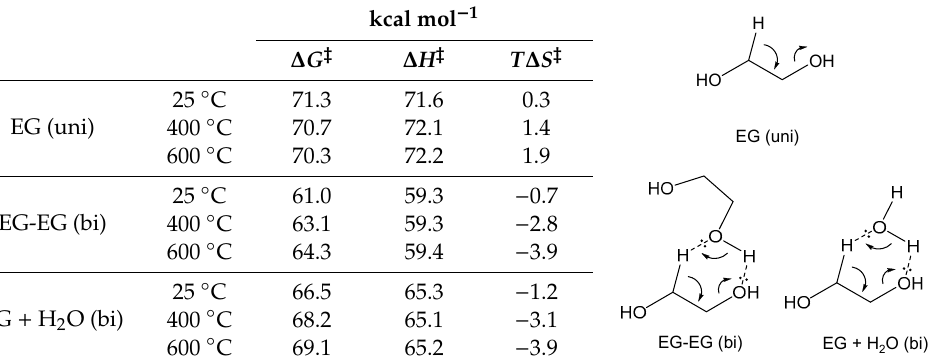
Figure 9. Possible heterolytic dehydration pathways for ethylene glycol (EG). The values next to the arrows represent the activation energies (kcal mol − 1 ), as calculated at the MP4(SDQ) // DFT(M06-2X) level. AA, acetaldehyde; uni, unimolecular mechanism; and bi, bimolecular mechanism (EG-EG). Table 2. The ∆ G ‡ , ∆ H ‡ , and T ∆ S ‡ values (kcal mol − 1 ) calculated for the dehydration of ethylene glycol (EG) by assuming the unimolecular (uni) and bimolecular (bi, EG-EG, and EG-H 2 0) mechanisms at 25, 400, and 600 ◦ C from the minimum energies of the transition states, as calculated at the MP4(SDQ) // DFT(M06-2X) level. kcal mol − 1 Δ G ‡ Δ H ‡ T Δ S ‡ ∆ G ‡ EG (uni)